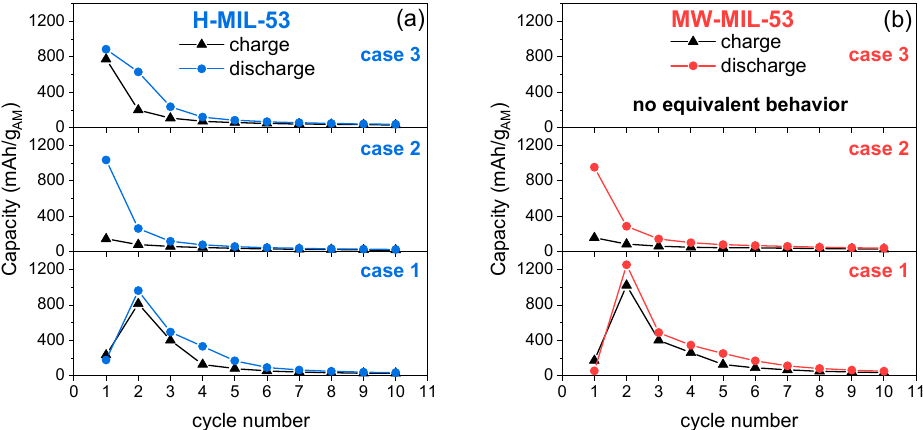
Figure 5. Discharge capacities at the first (light color bars) and second (dark color bars) discharges for all Li-O 2 batteries with H-MIL-53 (blue) or MW-MIL-53 (red).